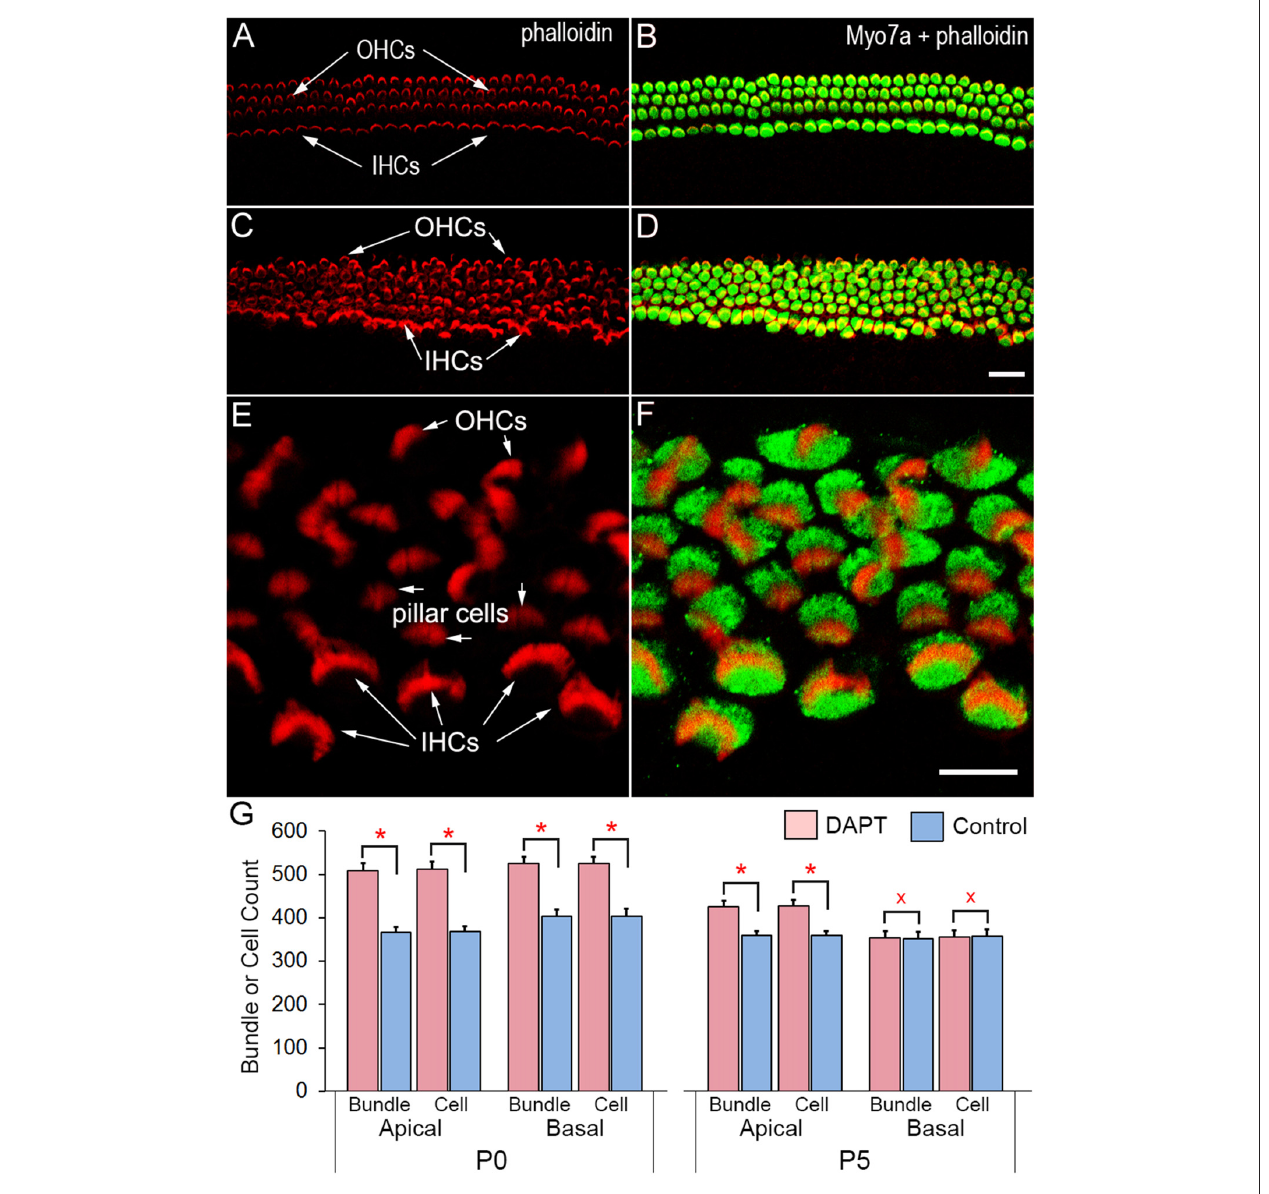
FIGURE 1 | Confocal images of stereocilia bundles and hair cells in cochlear explants of neonatal gerbils. The stereocilia bundle was labeled with rhodamine-phalloidin and soma was labeled with anti-Myo7a antibodies. (A,B) Images obtained from control cultures. (C,D) Images from DAPT-treated cultures. Bar in (D) : 10 µ m for (A–D) . (E,F) Images of a DAPT-treated culture under high magnification. Bar in (F) : 10 µ m for (E,F) . (G) Count of stereocilia bundles from cultures prepared from P0 and P5 gerbil cochleae. Two regions (1 mm in length in each region) in the apical and basal turns were examined. Statistical significance (marked by red asterisks with p ≤ 0.01 regarded as significant, n = 3, student’s t -test) was found between DAPT-treated and control groups. No statistical significance ( p ≥ 0.05, n = 3) was found between control and DAPT-treated cultures prepared from the basal turn of P5 gerbils (marked by red